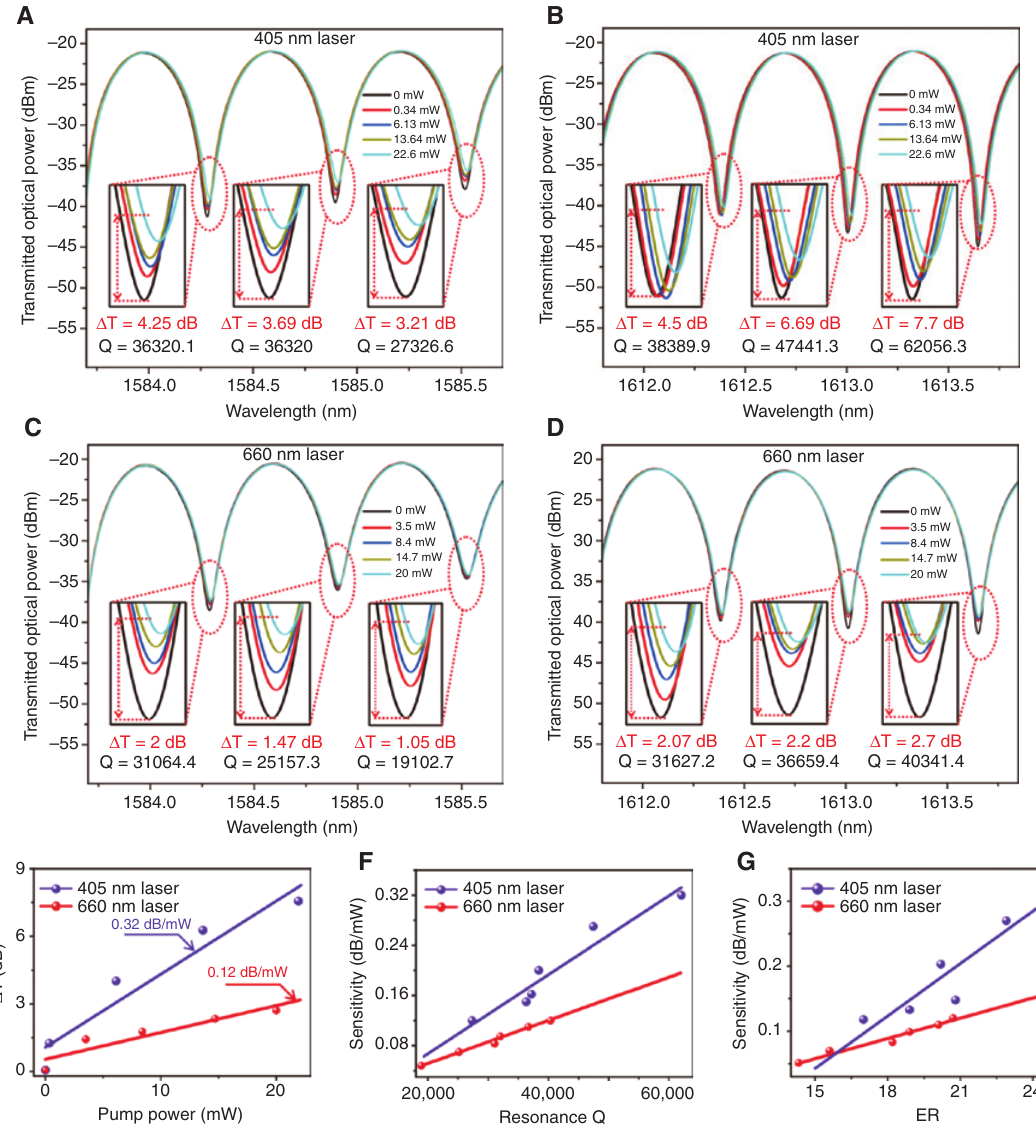
. Figure 4: Results of all-otical modulation experiments on the MKR coated with WSe 2 Transmission spectrum of MKR coated with WSe under 405-nm light illuminating with different power, including (A) 1583.7–1585.7 nm and 2 (B) 1611.8–1613.9 nm in wavelength. Transmission spectrum of MKR coated with WSe under 660-nm light illuminating with different power, 2 including (C) 1583.7–1585.7 nm and (D) 1611.8–1613.9 nm in wavelength. (E) Linear fit of Δ T under 405- and 660-nm light versus pump power at wavelength of 1613.6 nm. Linear fit of sensitivity under 405- and 660-nm light versus (F) resonance Q and (G) ER for the selected = ~ 1584.3 nm, λ = ~ 1584.9 nm, λ = ~ 1585.5 nm, λ = ~ 1612.4 nm, λ = ~ 1613.0 nm, λ = ~ 1613.6 resonance positions at λ res res res res res res